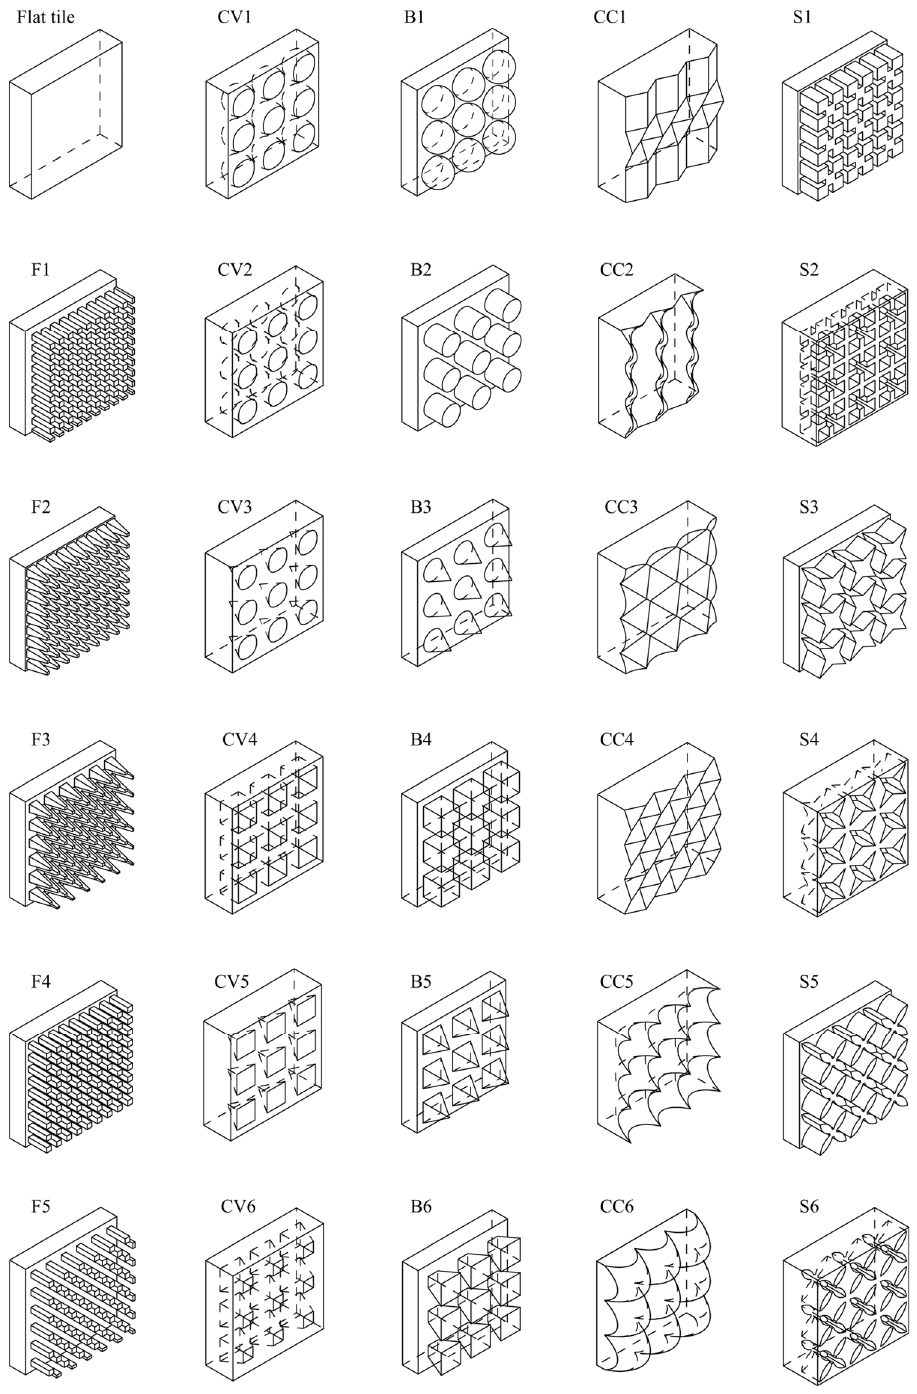
Figure 1. Flat and sculptured tiles: fur (F), cavities (CV), bumps (B), cacti (CC), and sponges (S).